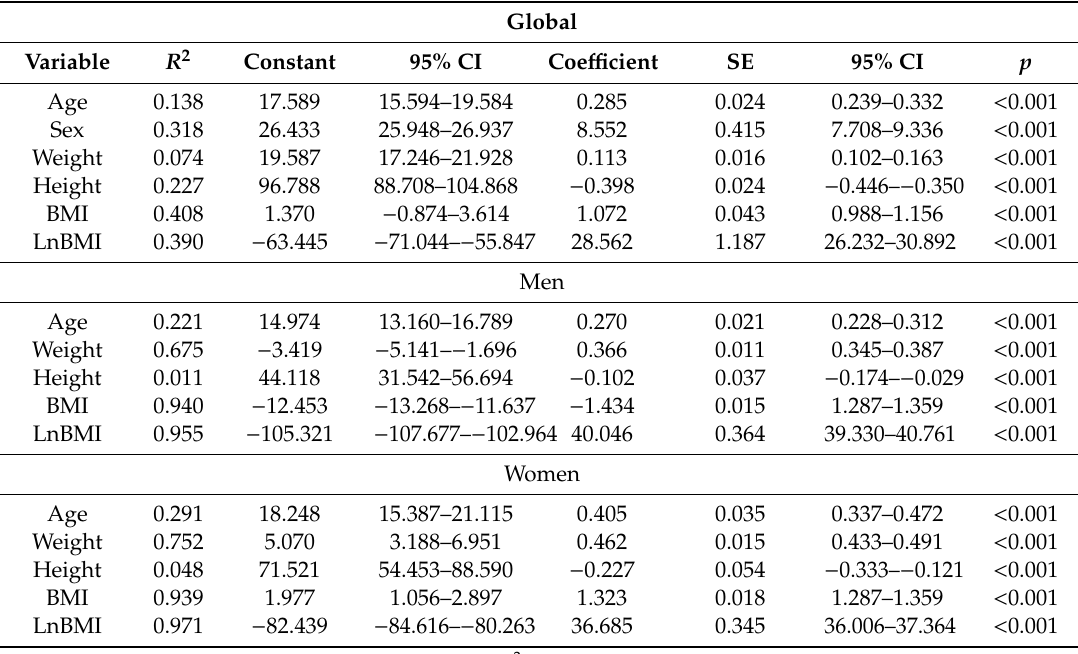
Table 3. Raw simple